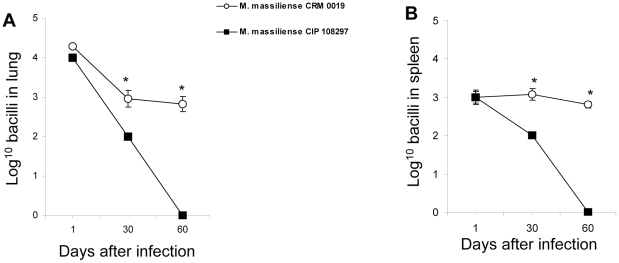
Increased bacteria in the lungs and spleens of the Brazilian epidemic strain M. massiliense CRM-0019 infected IFNγ-KO mice.Bacterial counts in the lungs (A) and spleens (B), on days 1, 30 and 60 from IFNγ-KO mice infected with a high dose aerosol of the epidemic strain M. massiliense CRM-0019 (open circle) and M. massiliense CIP 108297 (solid square) were compared. Results are expressed as the average (n = 5) of the bacterial load in each group expressed as Log10CFU, ± standard error mean (SEM). Student t-test, *p<0.050.